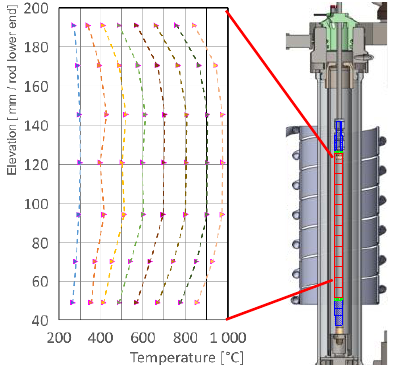
Fig. 6. Axial thermal profile in the VINON furnace (qualification test)